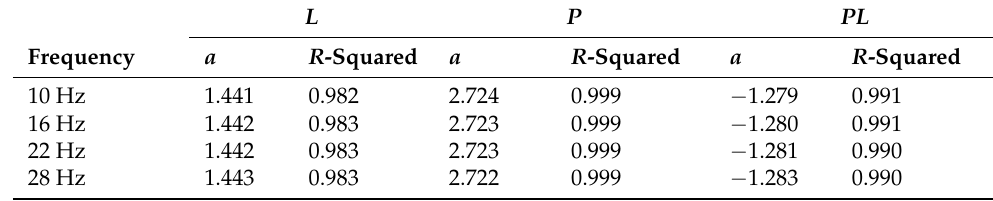
Figure 15. Logarithmic relationship of aerodynamic performance with r 2 . Symbols are raw data, and solid lines are fitted data. ( a ) Mean lift with r 2 . ( b ) Aerodynamic power with r 2 . ( c ) Power loading with r 2 . Table 7. Coefficients for the power relationship between aerodynamic performance and r 2 at different flapping frequencies.